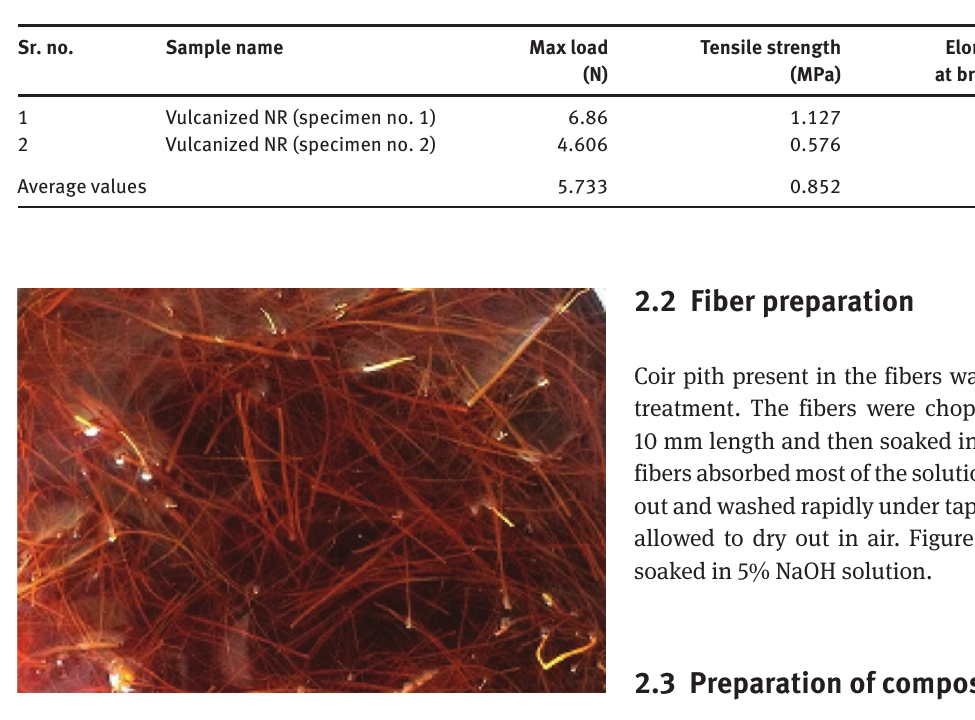
Figure 2: Coir fibers soaked in 5% NaOH solution.